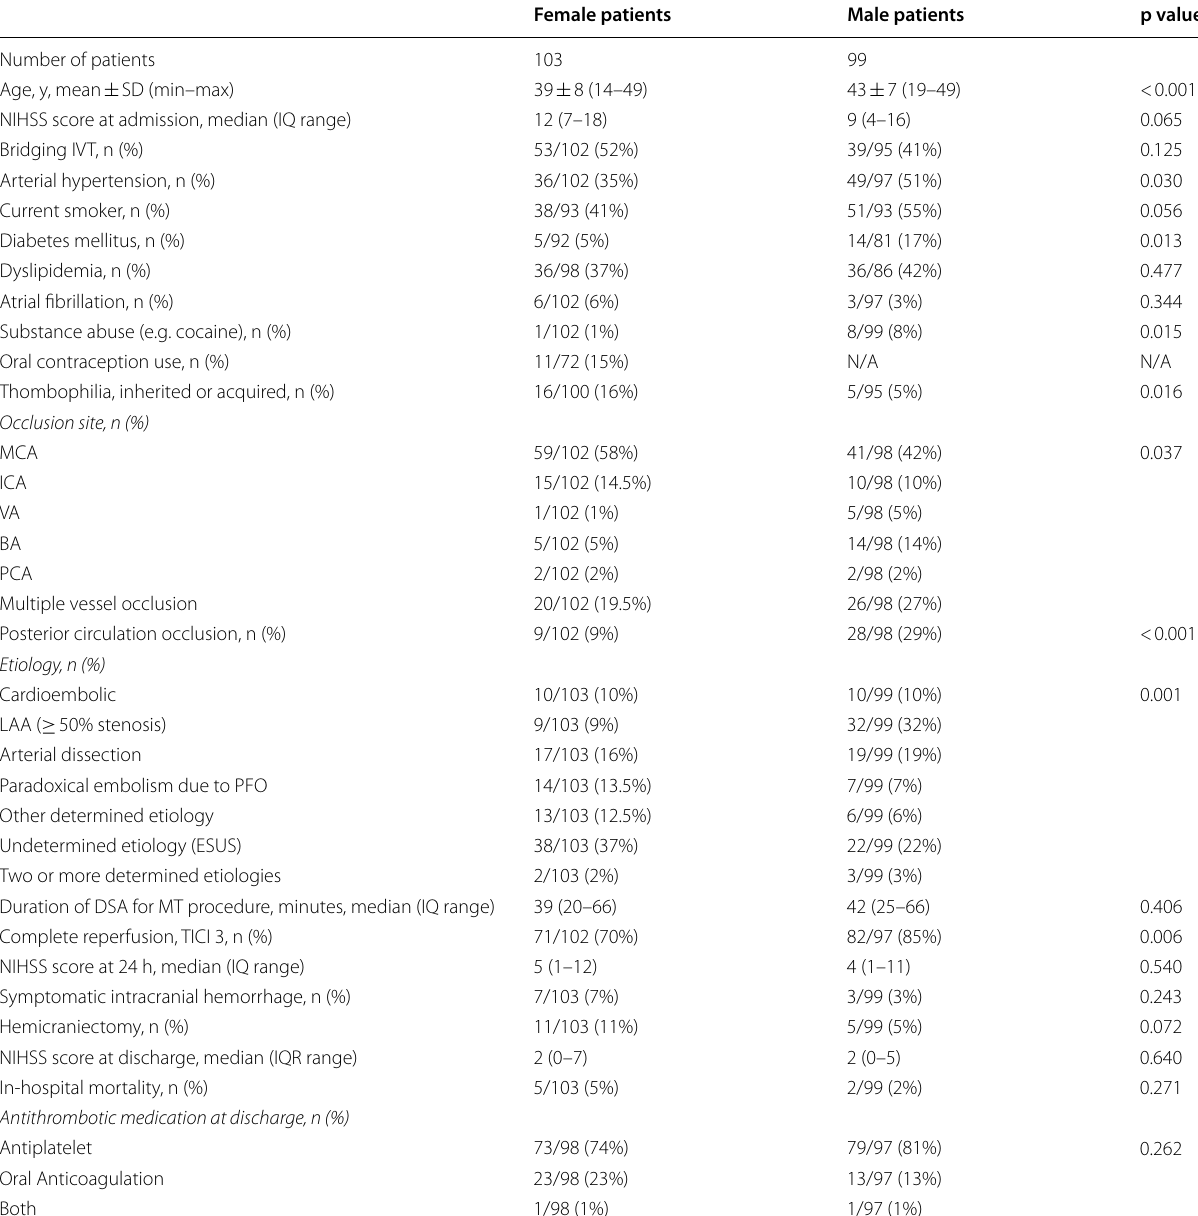
Table 1 Comparison of patient characteristics, procedural and outcome parameters in young female and male acute ischemic stroke patients undergoing MT (all given percentages include missing